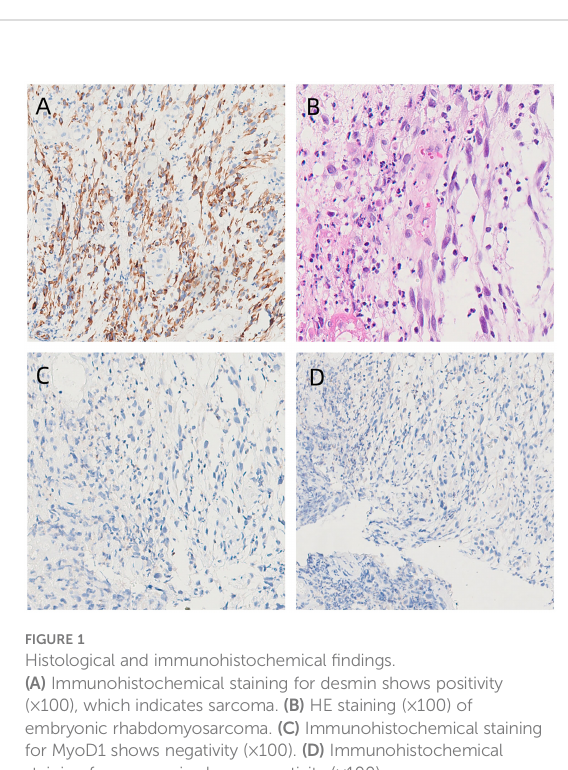
FIGURE 1 Histological and immunohistochemical fi